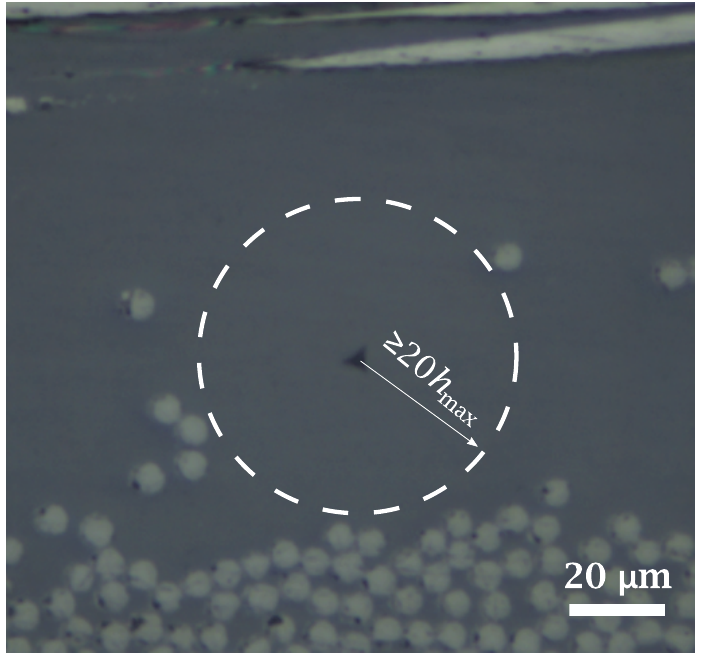
Figure 10. Image of an in situ indentation on PEEK matrix. Indentations were performed on resin pockets (marked by dashed line) to avoid the influence of surrounding fibers.